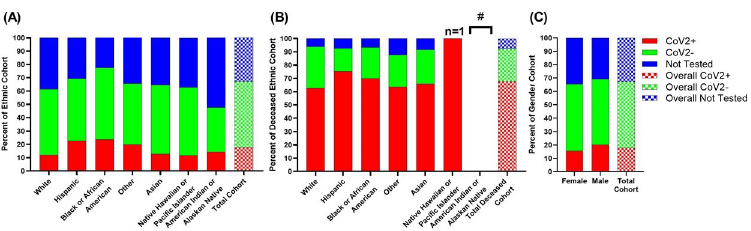
Fig 2. CoV2 testing distribution of Mount Sinai Health System by race and ethnicity and by sex. (A) Of the 39,539 patients captured in the Mount Sinai Health System with a COVID-19 related encounter, the majority of patients across all racial and ethnic groups either tested negative for CoV2 (49.4%) or were not tested (32.8%). Within this population, Black or African Americans (77.5%) and Hispanics (69.3%) had the highest positive test rates. (B) 67.7% of the deceased population tested positive for CoV2, 24.6% tested negative, and 7.6% were not tested. Only 1 individual identified as Native Hawaiian or Pacific Islander is represented in the deceased population and tested positive. In our catchment group, no American Indian or Alaskan Natives passed away (#). Rates of testing were similar across the remaining ethnic and racial groups. (C) CoV2 testing distribution across sexes. The cohort consists of 52.5% females and 47.5% males. Rates of testing were higher in males (69.2%, 12,980/18,769), who also tested positive for CoV2 more than females (p < 0.0001). https://doi.org/10.1371/journal.pone.0254707.g002 The individuals who tested negative or were not tested (82.2% of the MSHS cohort) also capture individuals with false-negative qRT-PCR results and individuals with clinical presenta- tion, imaging, and labs consistent with COVID-19. Interestingly, there was a significant associ- ation when comparing qRT-PCR testing between the four major ethnic groups. Blacks and Hispanics had higher positive testing rates compared to other groups with 23.8% (n = 1,977) and 22.7% (n = 1,919), respectively (Table 2A). Table 2. CoV2 testing distribution of Mount Sinai Health System by race and ethnicity across the (A) total patient population and (B) deceased patient population.